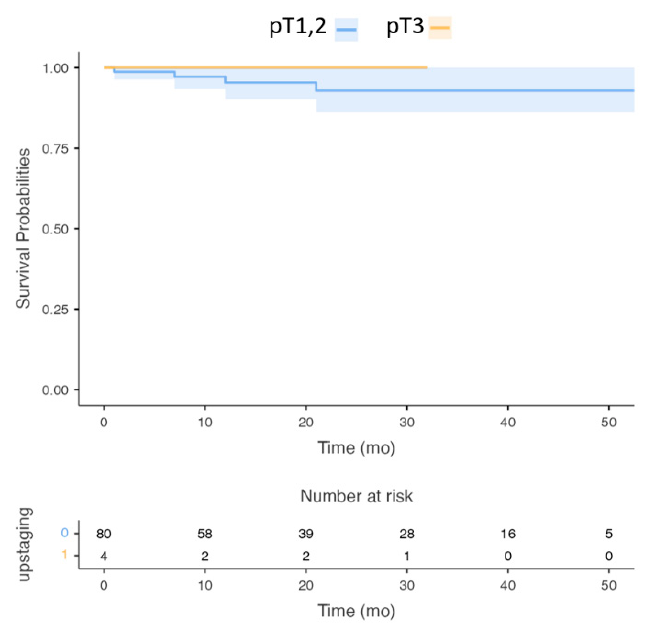
Figure 2. Survival Curve: The 5-year DSS of patients upstaged to pT3 (eighth AJCC staging system) from pT1, pT2N0M0 (seventh AJCC staging system). ( p -value > 0.05).